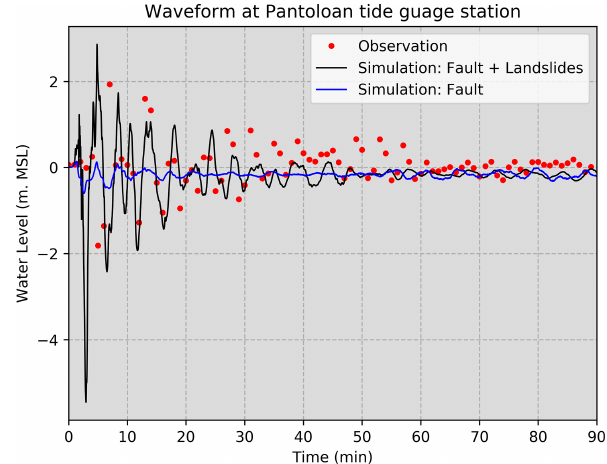
Figure 10. Time series of sea level at the Pantoloan tide gauge with de-tided sea level data. The black line represents the simu- lated waveform based on submarine landslides and seismic faults, the blue line represents the simulated waveform based on seismic fault, and the red dot represents the sea level record at the Pantoloan tidal